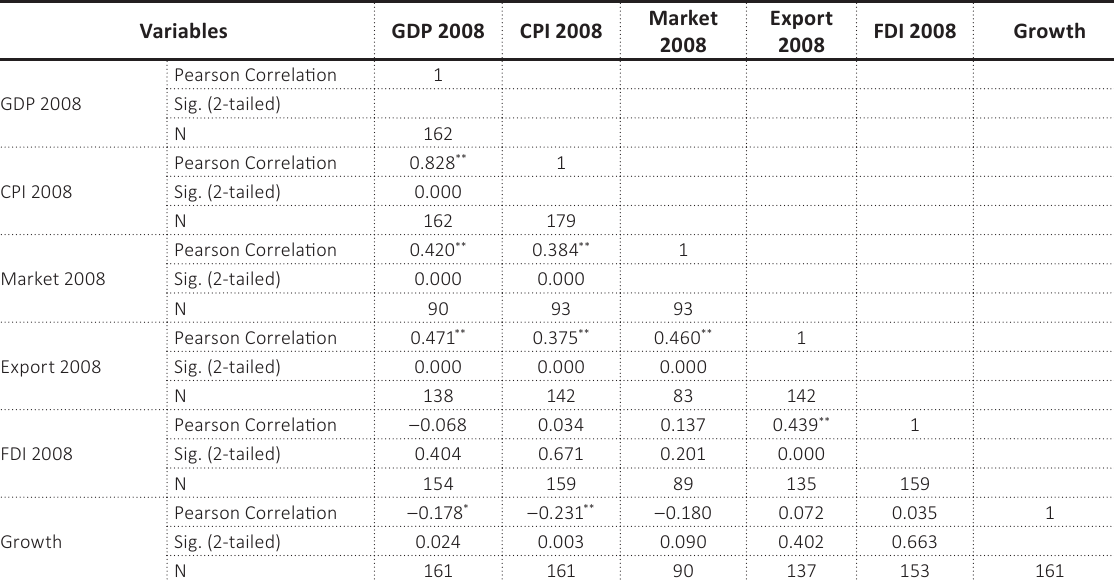
Table 5. Pearson correlation matrix for each of the six variables for